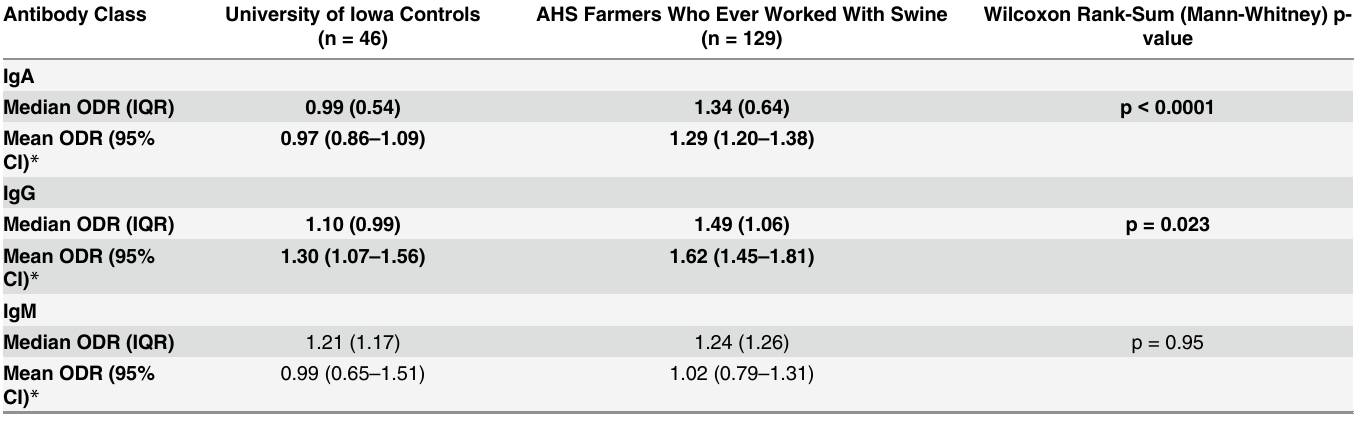
Table 2. Anti- Campylobacter jejuni Antibodies: Farmers vs. Controls (n = 175). Antibody Class University of Iowa Controls AHS Farmers Who Ever Worked With Swine (n = 46) (n =